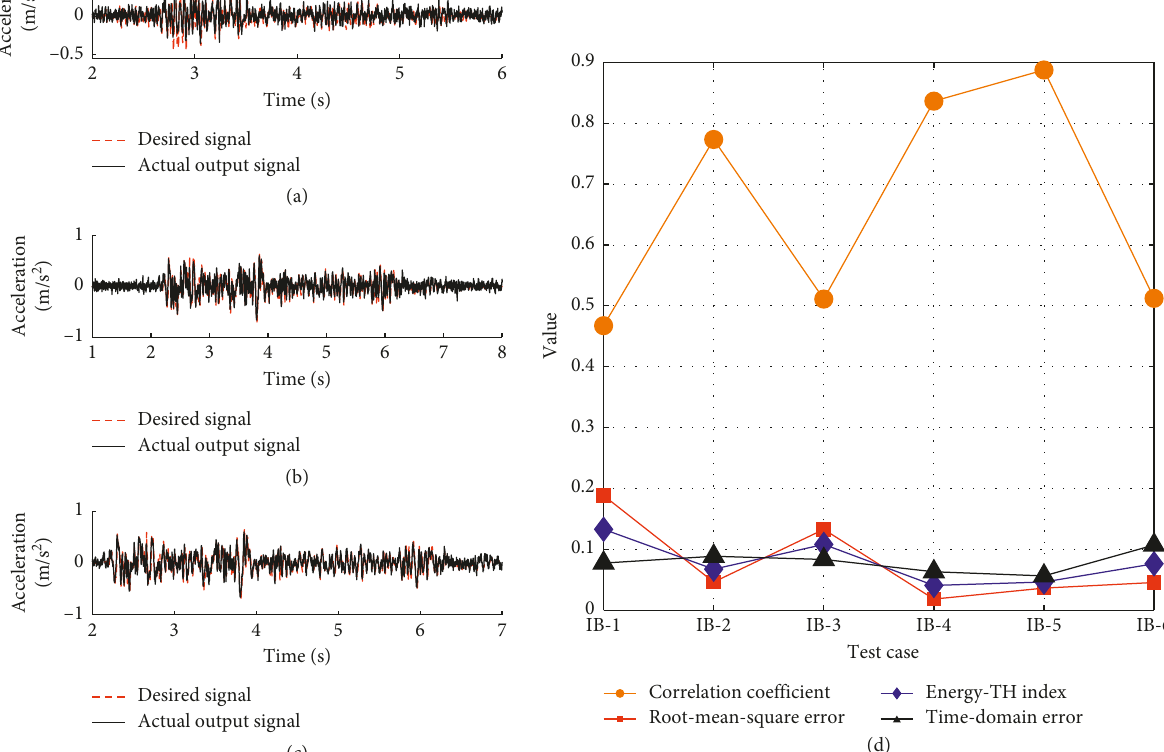
Figure 13: Shake table’s output and corresponding error of different test cases with isolated building. (a) Case IB-1; (b) case IB-2; (c) case IB- 3; (d) output errors of test